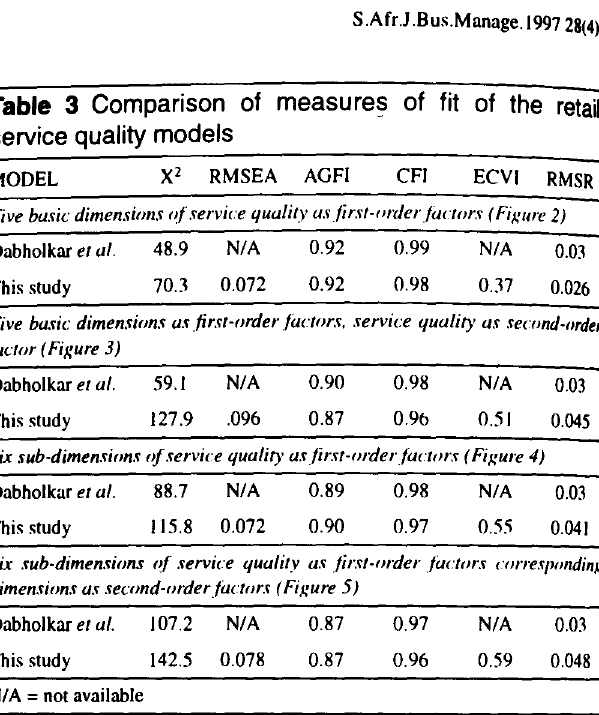
Table 3 Comparison of measurel:i of fit of the retail service quality